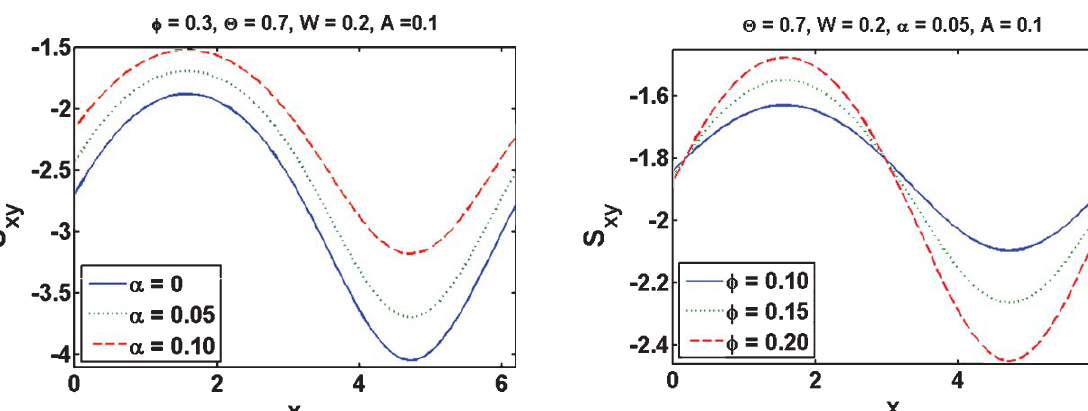
Fig.4. Variationin u ( y )against y fordifferentvaluesoffluidparam- eter ( W ).